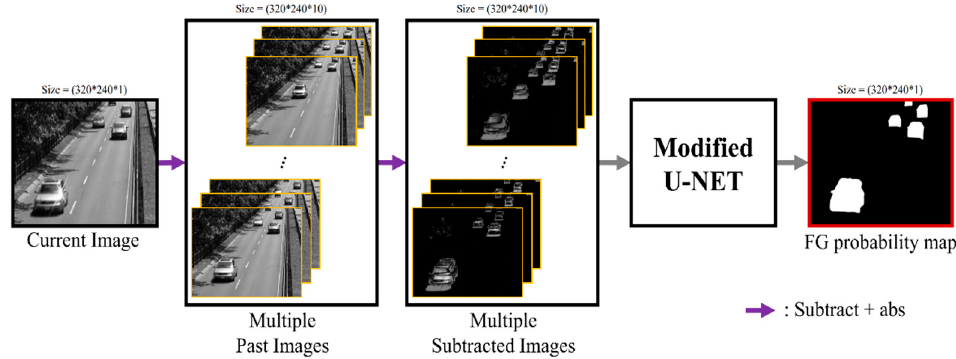
Figure 2. Foreground object detection by U-Net with multiple difference images as input.